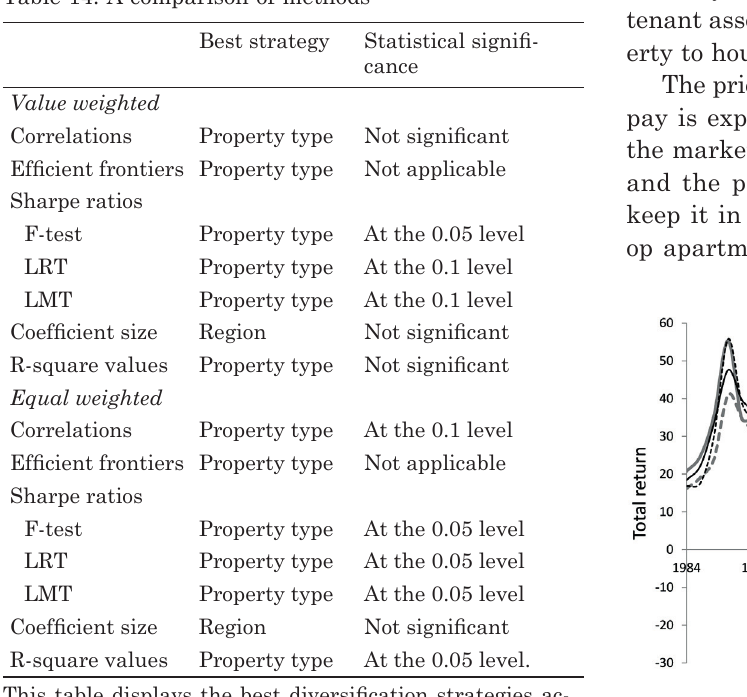
fig. 2. The pure value-weighted index for different property